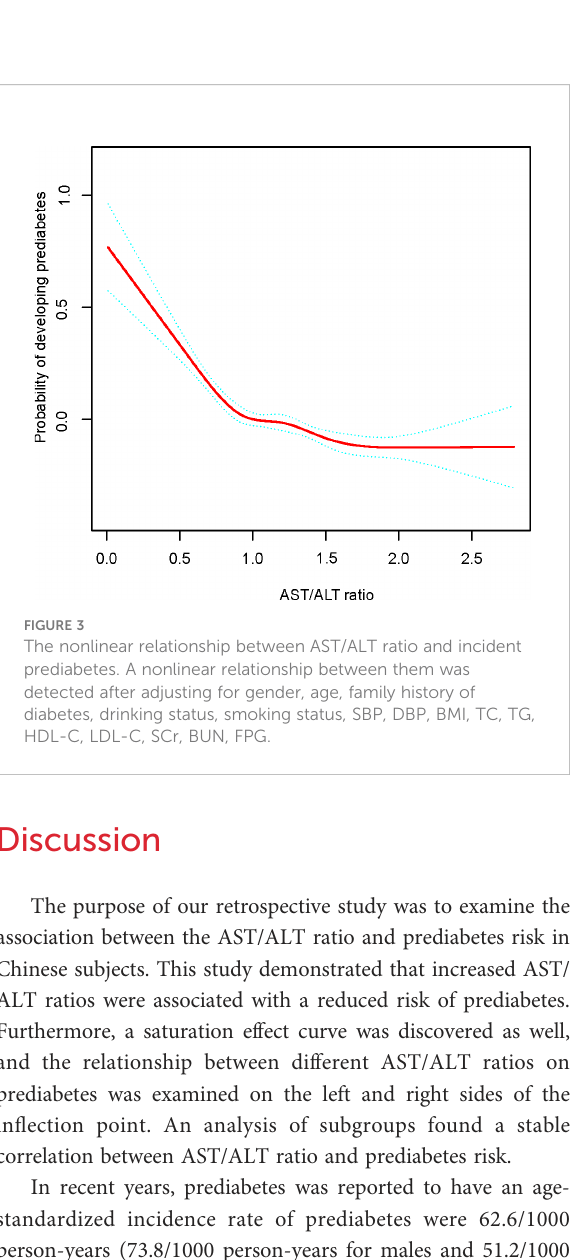
Fitting model by standard linear regression Fitting model by two-piecewise linear regression In fl ection point of AST/ALT ratio